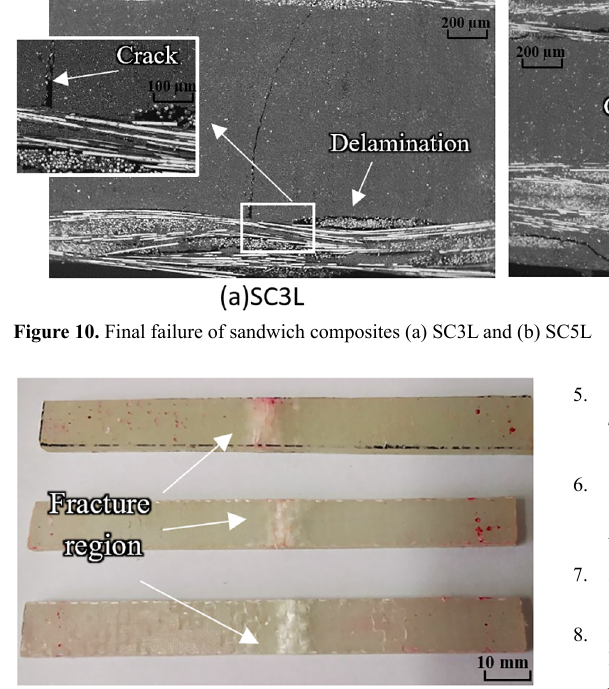
Figure 11. Fracture characteristic in the